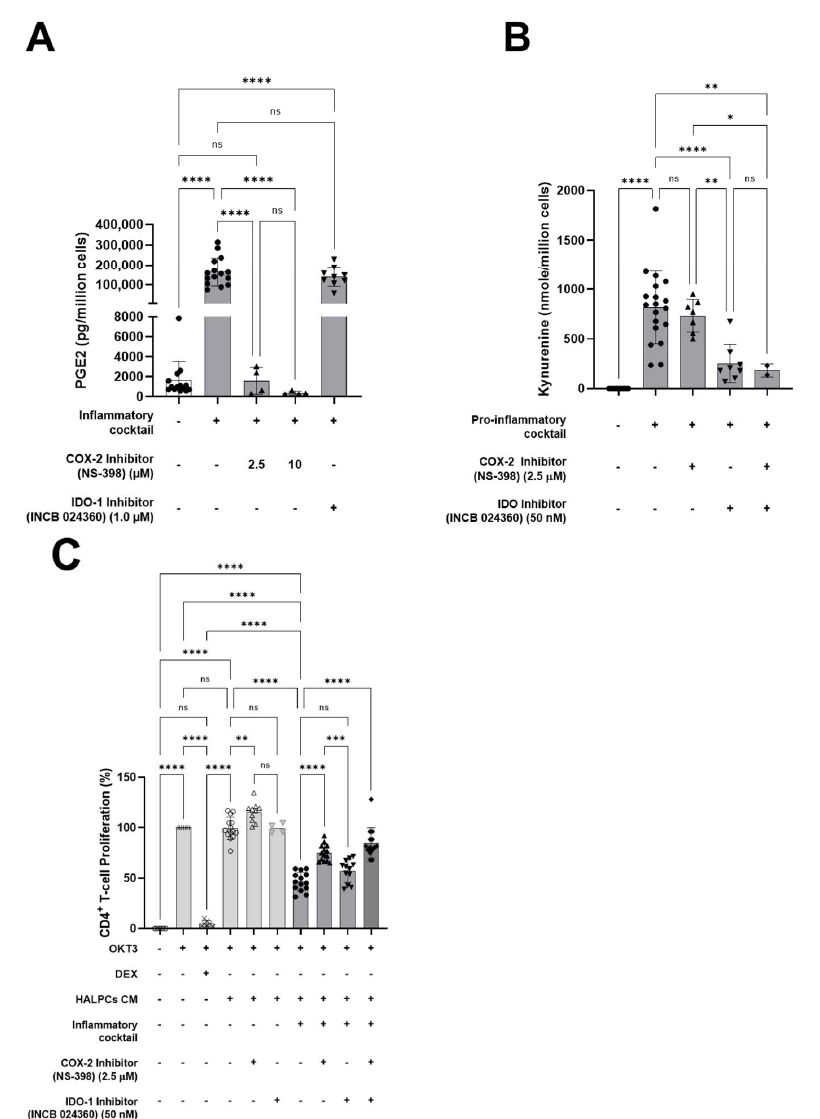
Figure 3. Mechanism(s) of action involved in the inhibition of APC-induced CD4 + T-cell activation by HALPCs in pro-inflammatory conditions. ( A ) Effect of IDO and COX-2 inhibitors on PGE2 secretion by HALPCs ( n ≥ 3). ( B ) Effect of IDO and COX-2 inhibitors on kynurenine production by HALPCs ( n ≥ 3). ( C ) Effect of IDO and COX-2 inhibitors on inhibition of APC-induced CD4 + T-cell proliferation by HALPCs ( n ≥ 3). HALPCs: human allogeneic liver-derived progenitor cells; CM: conditioned medium. ns: not significant; *: p < 0.05; **: p < 0.01; ***: p < 0.001; ****: p < 0.0001 (Tukey Multiple Comparison Test).